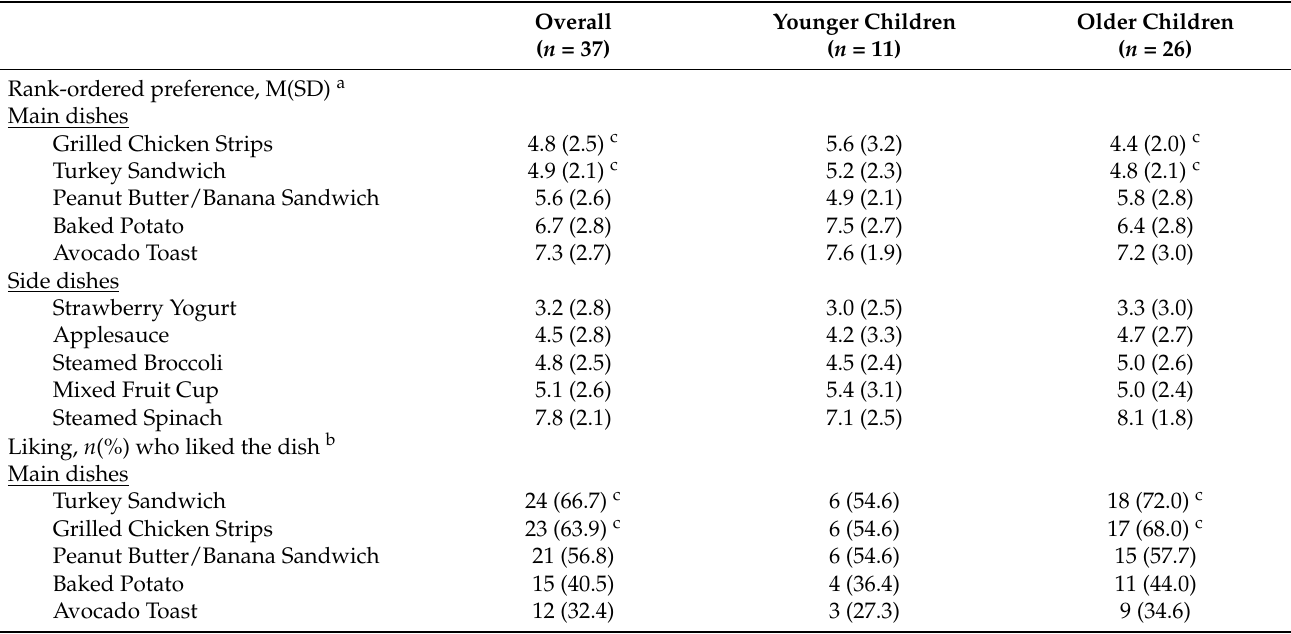
Table 2. Children’s average ranked preference and self-reported liking of each tasted main and side